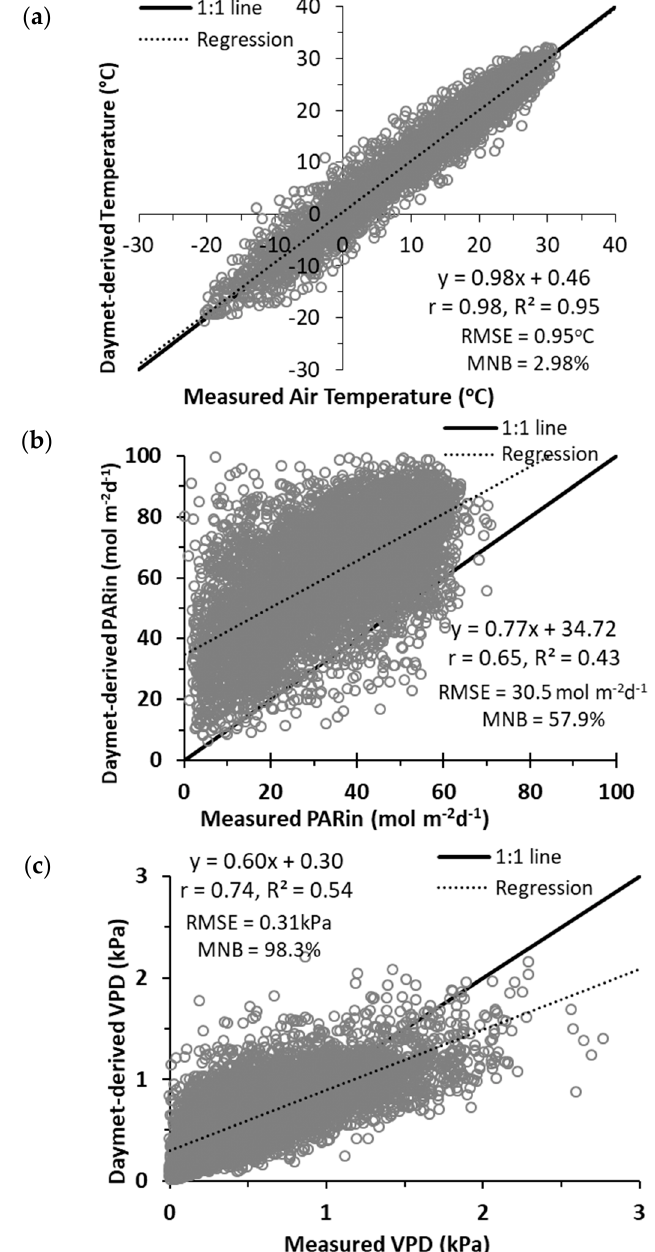
Figure 7. Daymet-derived daily values as functions of AmeriFlux measured values for ( a ) average daily temperature, ( b ) PARin, and ( c ) vapor pressure deficit (VPD).